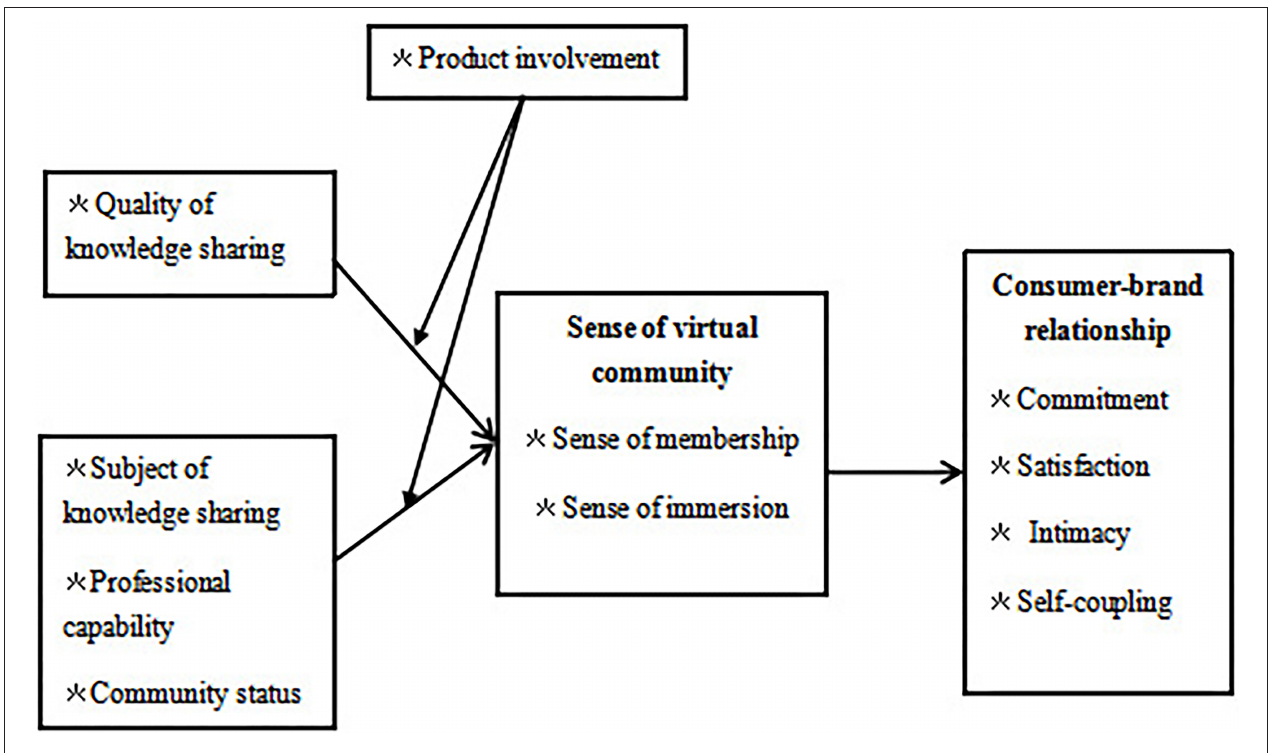
FIGURE 1 | Proposed